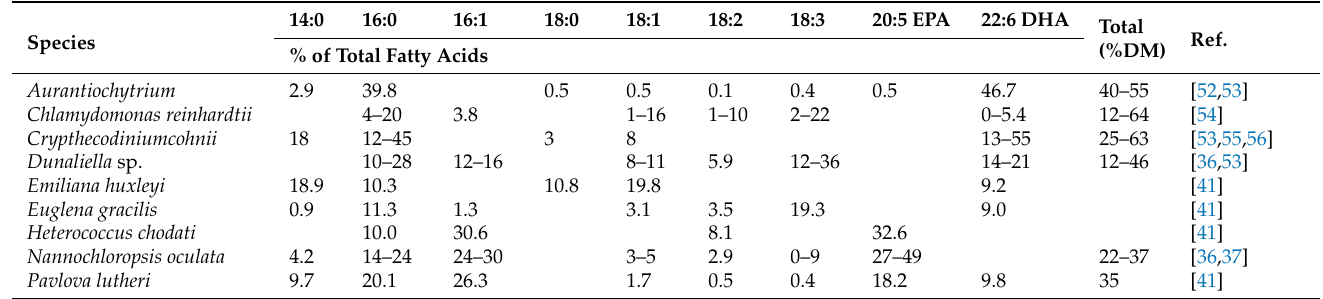
Table 1. Fatty acid composition (% of total fatty acids) of different microalgae